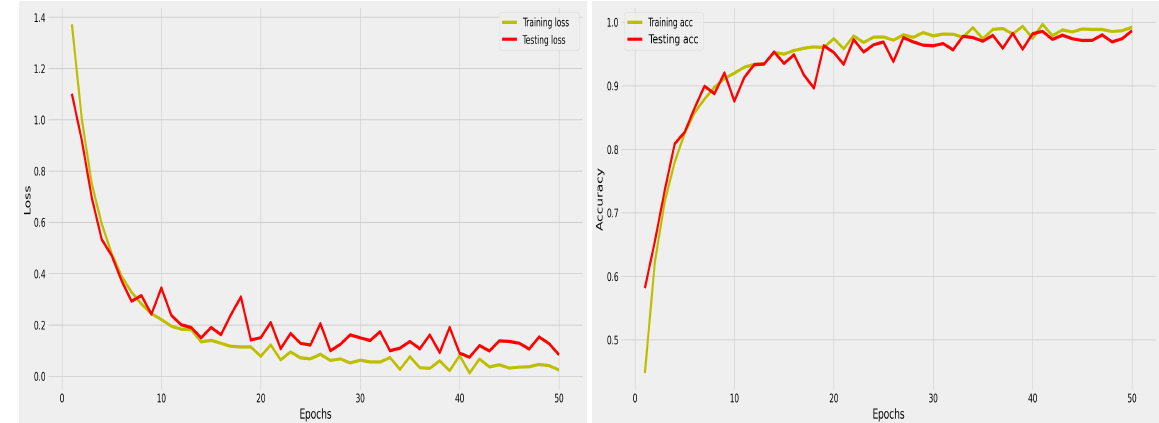
Figure 5. The loss and the accuracy training and validation curves for the HAM10000 dataset.